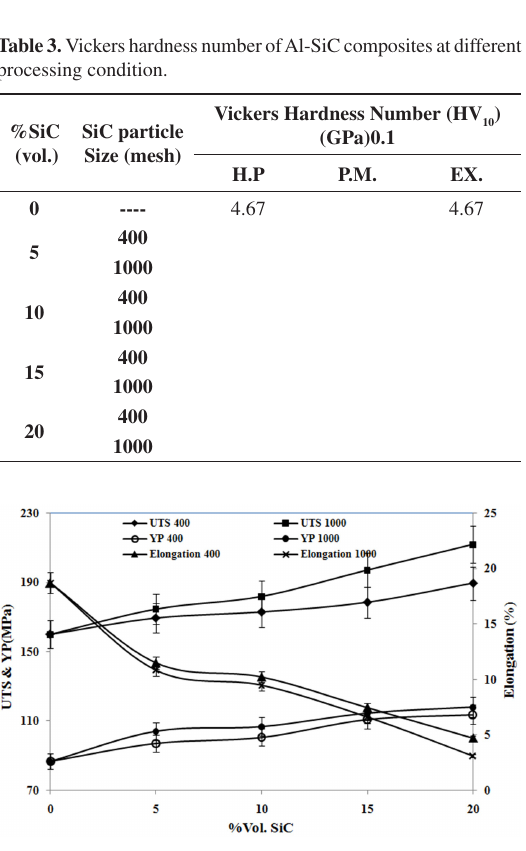
porosity in HP samples (refer to Table 2). These porosities act as crack nucleation in tensile test that leads to lower YP. On the other hands, the applied pressure during compression test leads to closing of these porosities. There is no fracture on compression test of ductile materials; therefore elongation of these materials cannot be measured. There is one approach to measure the elongation by measurement of the sample strain at arbitrary known stress.